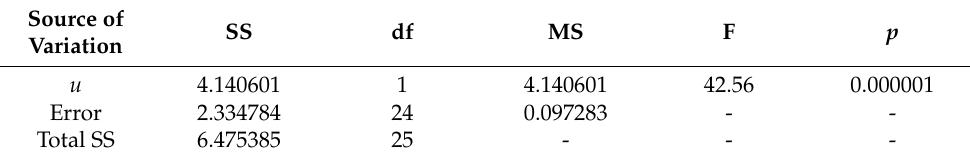
Table 10. Model of Vicat softening temperature VST—ANOVA table, R 2 = 0.64; R adj2 = 0.62. Source of